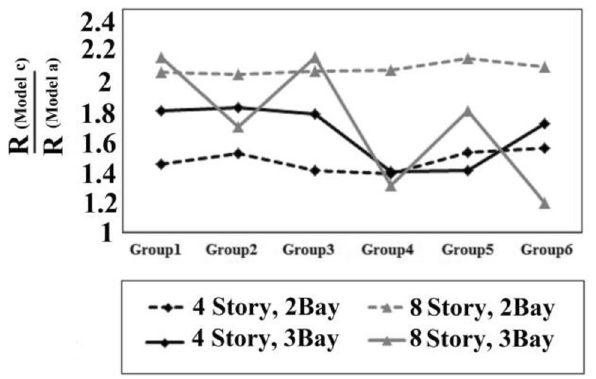
Fig. 17 Comparison of the response modification factors of the studied models of the 8-story 2-span structure